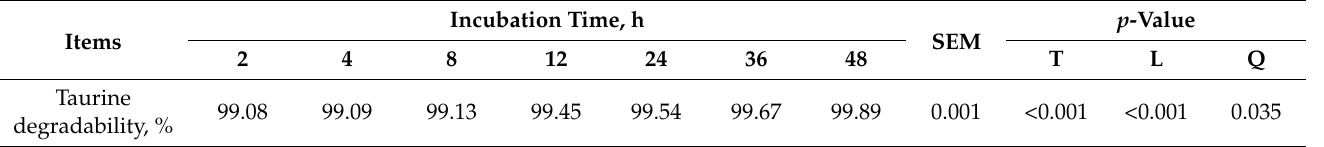
Table 3. Taurine degradability for in vitro rumen fermentation (Trial 1).